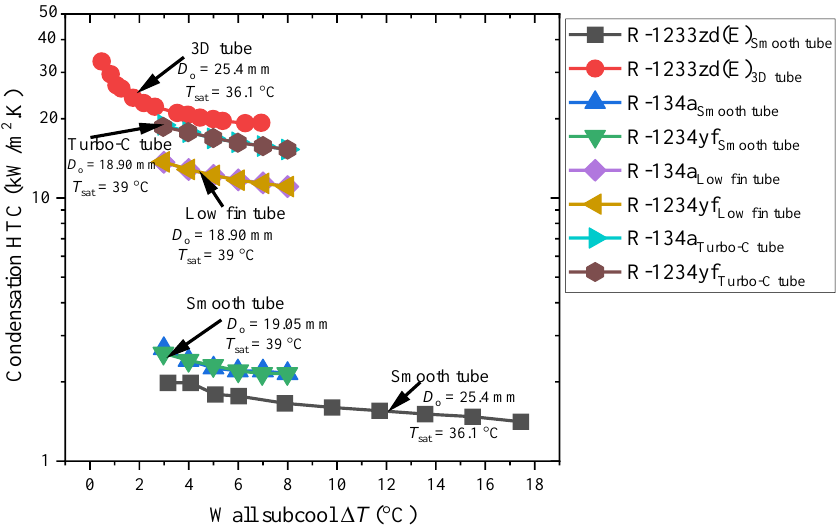
Figure 7. Condensation heat transfer performance of R-134a and R-1234yf on the smooth, low-fin, and Turbo-C tube and R-1233zd(E) on the smooth and 3D tube. Rectangular and circular solid connected line presents the Chen and Wu [14] study and the remaining symbols present the Park et al. [11] study.